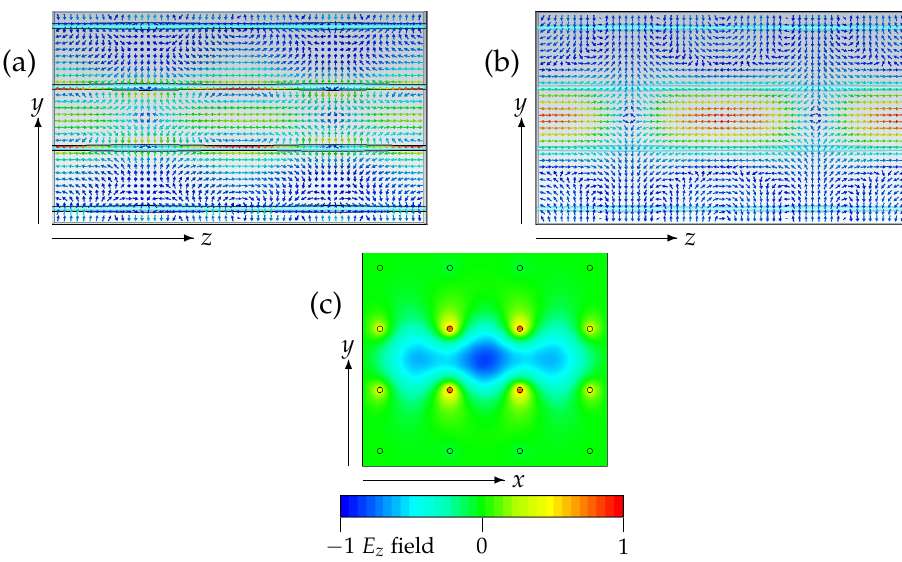
Figure 8. The field variation in our chosen longitudinal mode as present in a 4 × 4 array of infinitely long wires of varying radii in a waveguide. The distances between the wires are given by L x = 15 mm and L y = 13.06 mm. The single period of the longitudinal electromagnetic wave is given by L z = 80.60 mm. The dimensions of the waveguide are given by S x = 52.5 mm and S y = 45.71 mm. Thus, the distance of the wires closest to the waveguide walls and the walls are 1 shown as a vector on the ( y , z ) plane as ( a ) cut through the wires, and ( b ) cut between the wires. In ( c ), the longitudinal component E z is shown on the ( x , y ) . This plane is cut through the point z = 48.36